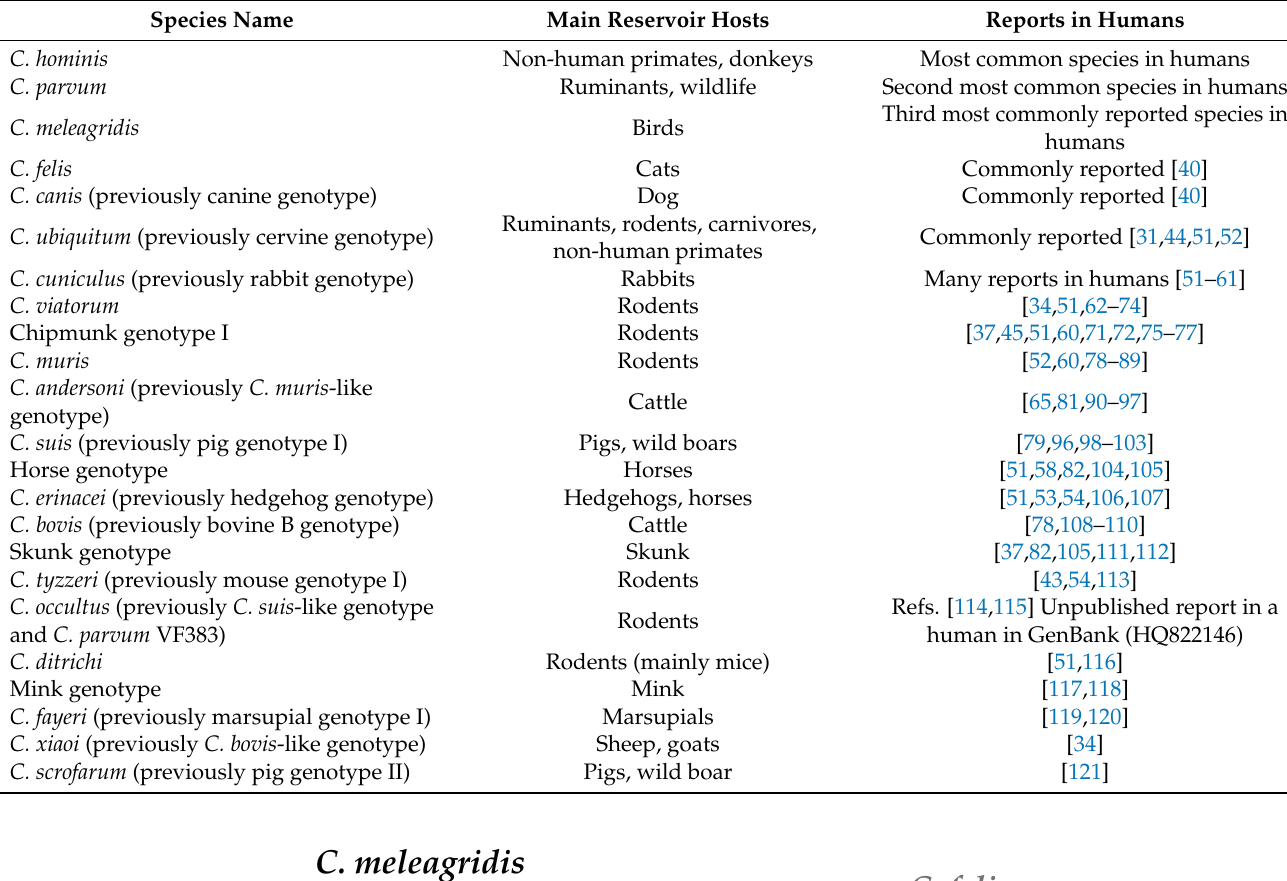
Table 1. Cryptosporidium species and genotypes in humans in order of frequency.